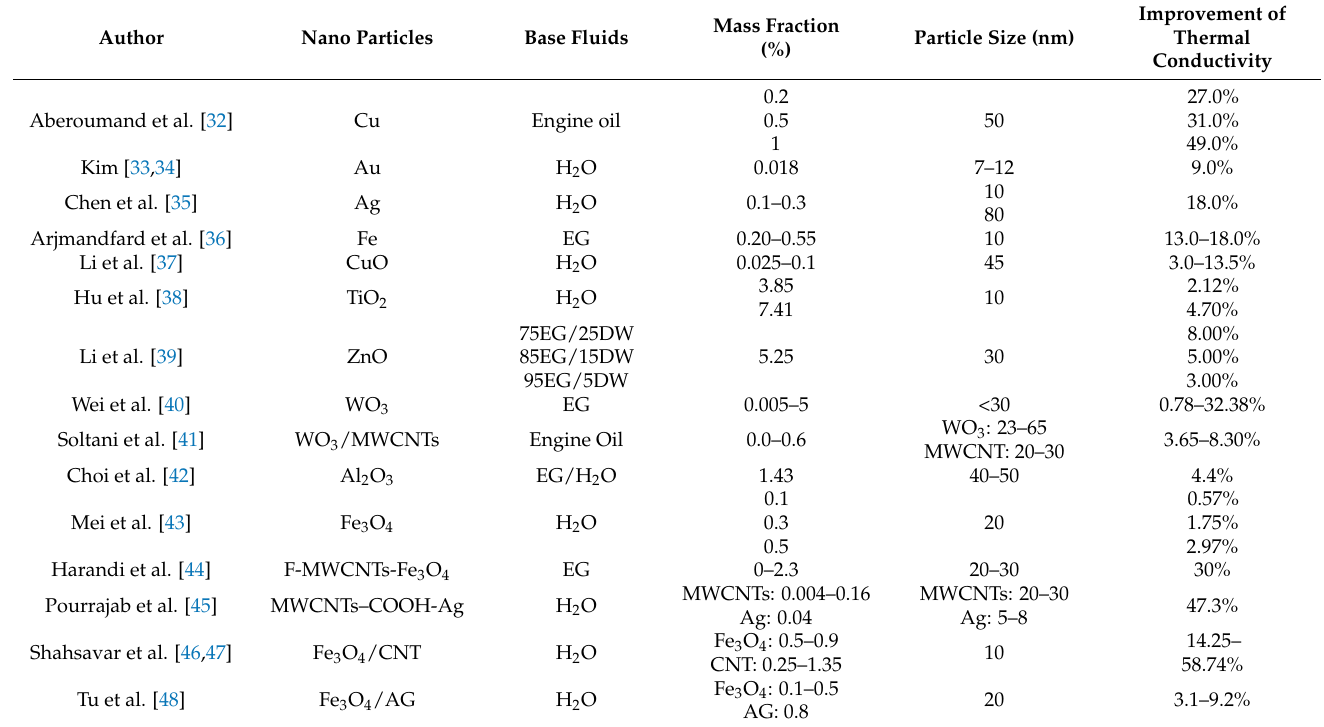
Table 1. Thermal conductivity of common